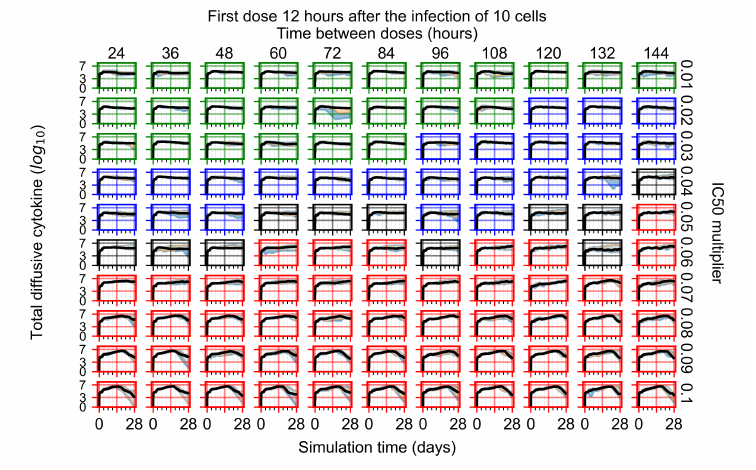
Figure A19. Diffusive cytokine amount, Y axis in log scale, and exponent values as tick